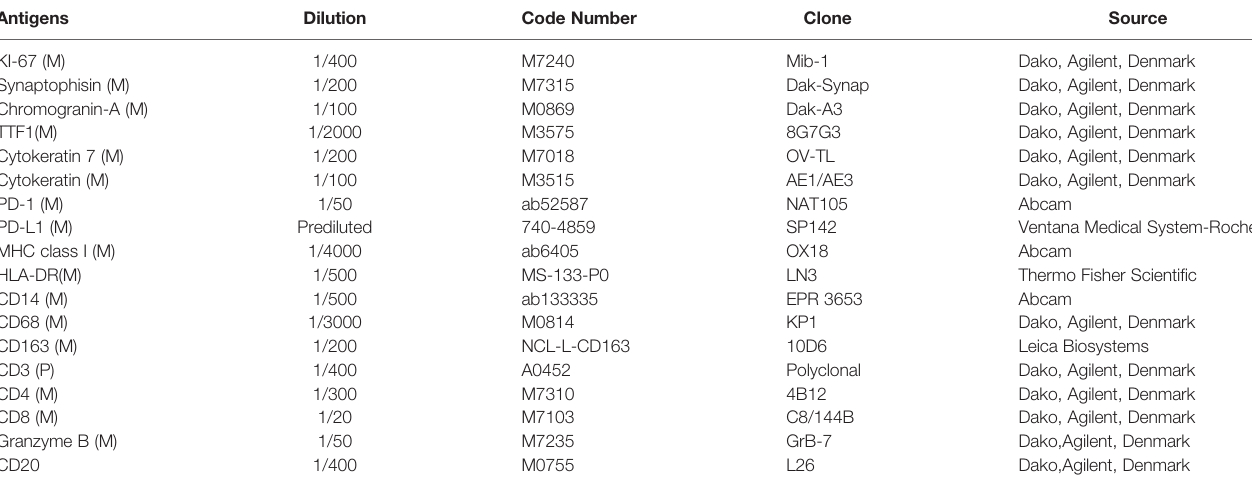
TABLE 1 | Antibody sources and